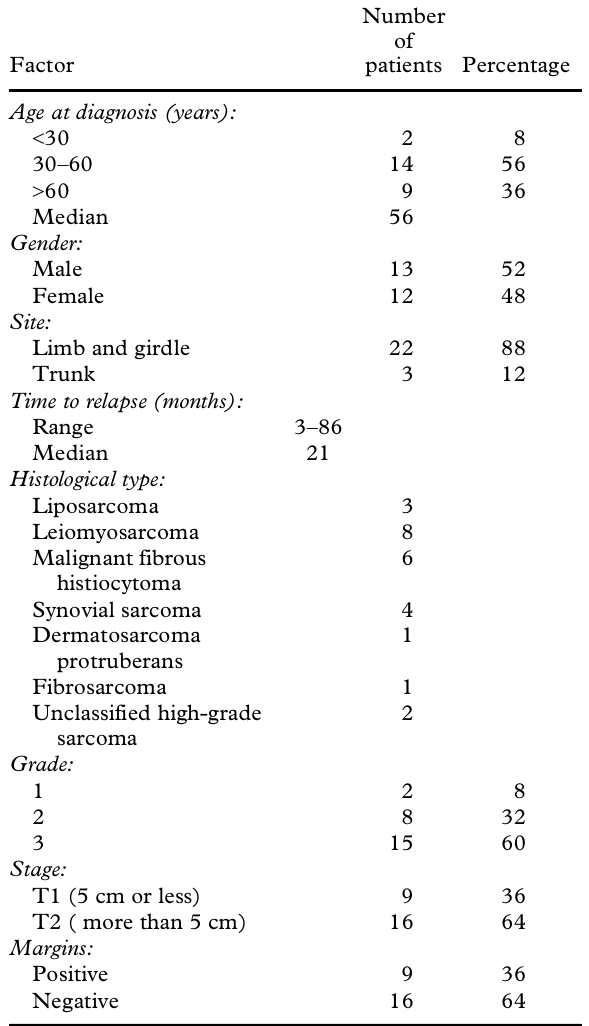
Table 1. Recurrences, patient and tumour characteristics